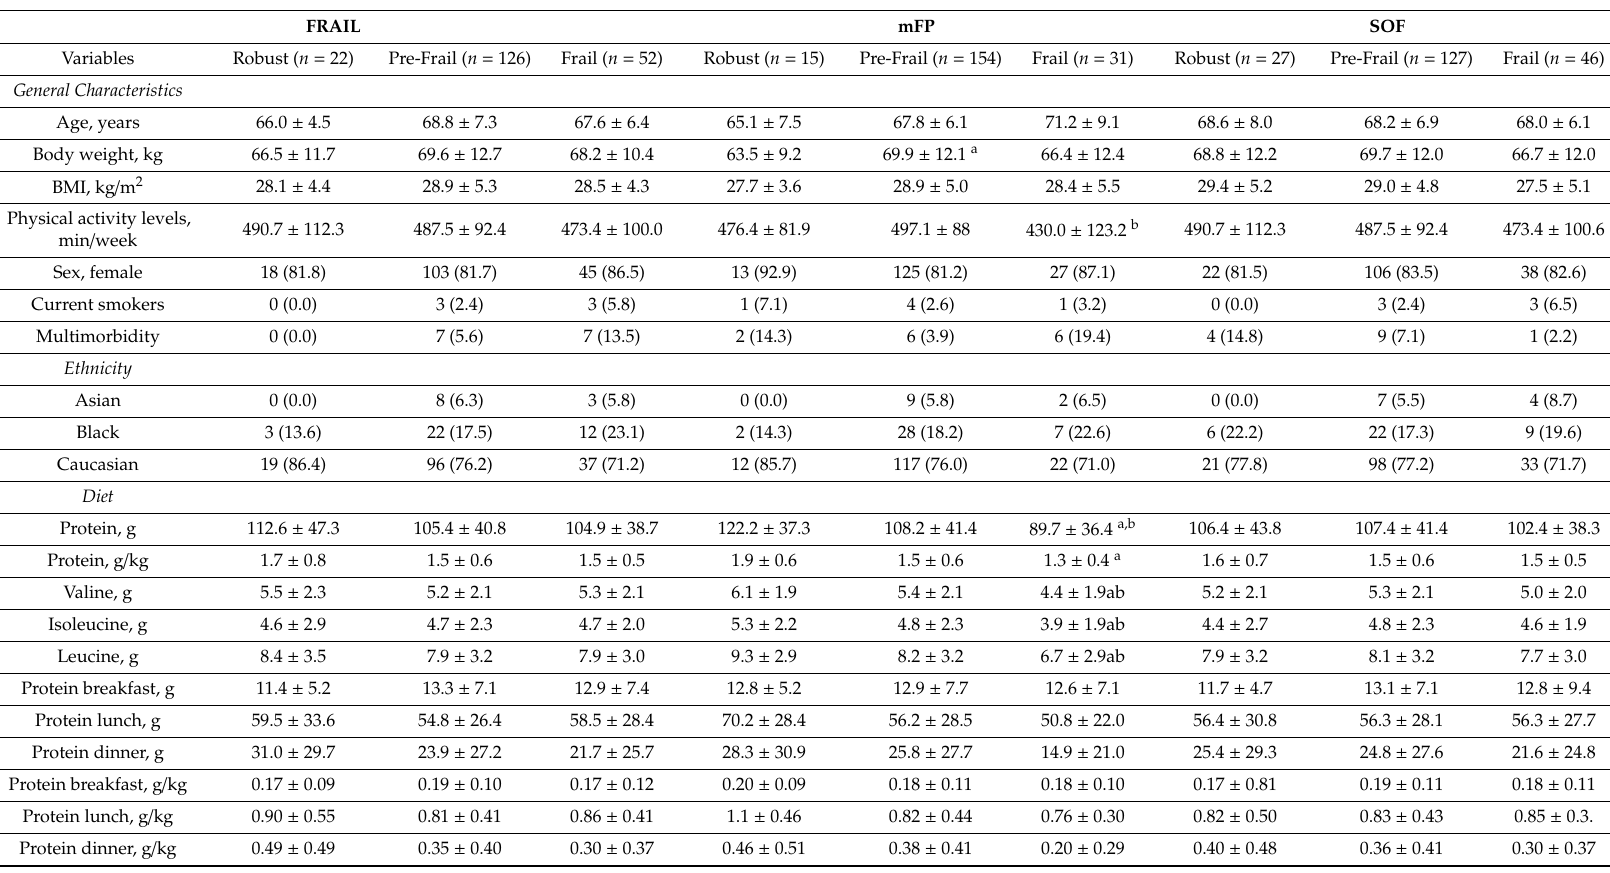
Table 1. Characteristics of study participants according to frailty status across frailty assessment